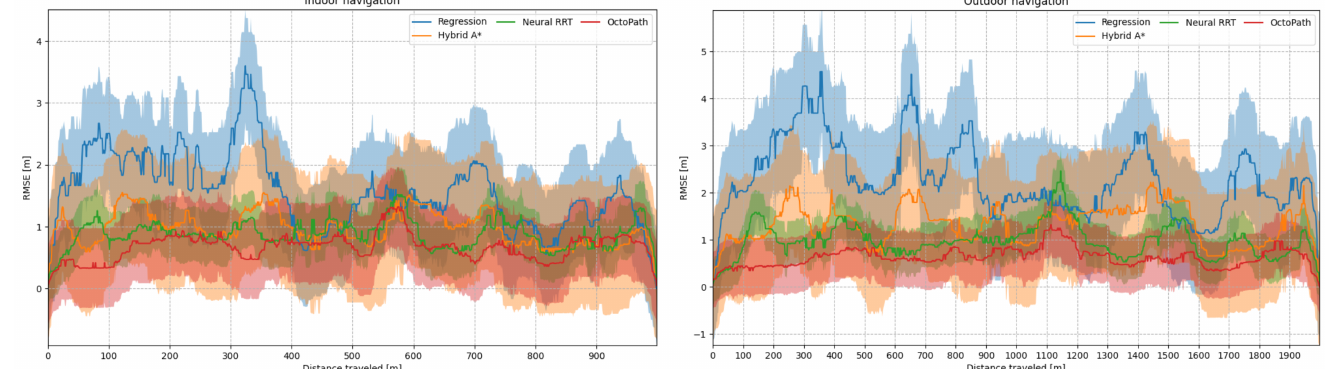
Figure 7. Mean (solid line) and standard deviation (shaded region) of the position error, computed as the RMSE from Equation (24) during indoor and outdoor testing scenarios.